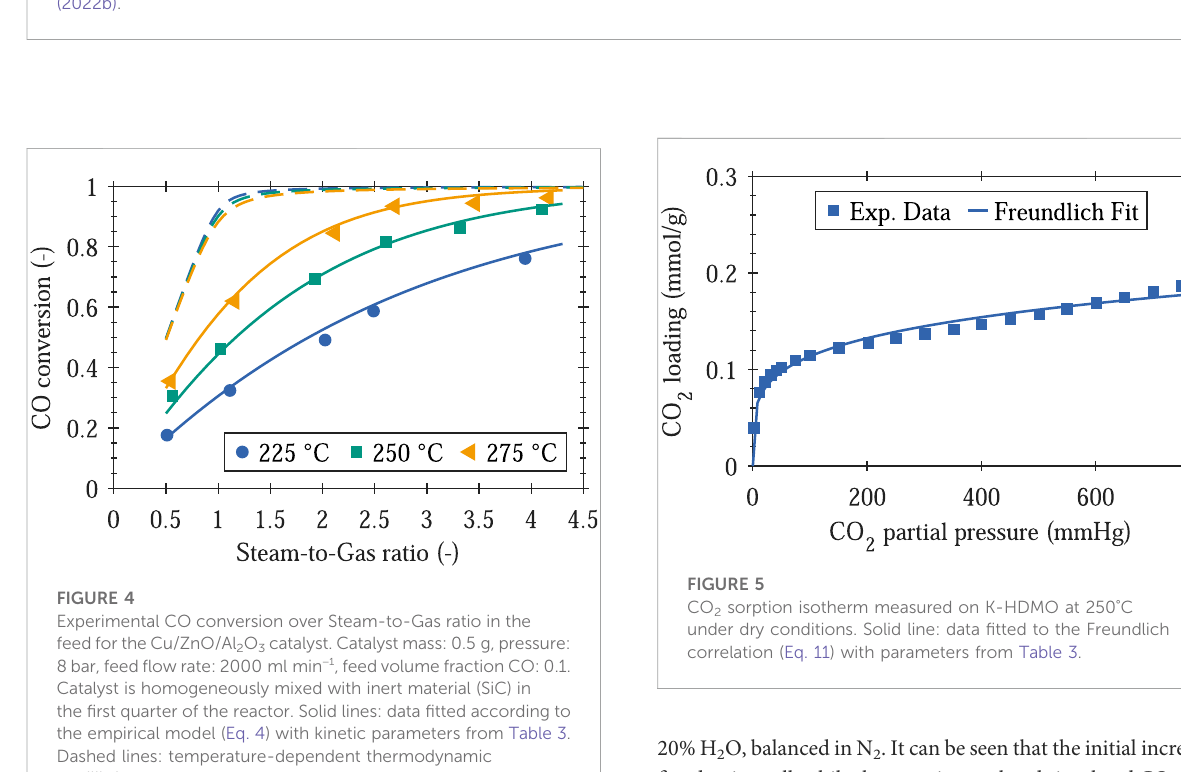
FIGURE 5 CO 2 sorption isotherm measured on K-HDMO at 250 ° C under dry conditions. Solid line: data fi tted to the Freundlich correlation (Eq. 11) with parameters from Table 20% H 2 O, balanced in N 2 . It can be seen that the initial increase is fi tted quite well, while the experimental and simulated CO curves in the upper part deviate when approaching the fi nal state.